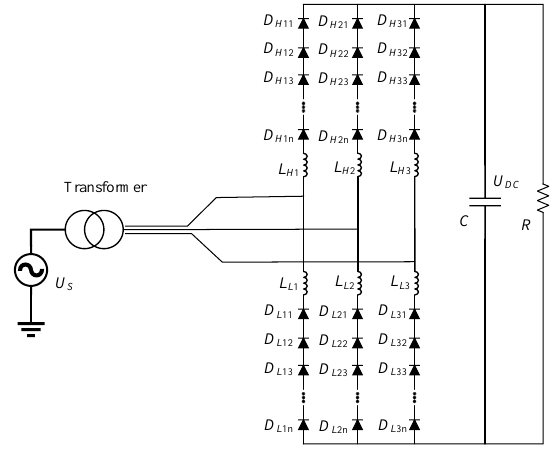
Figure 1. Structure of high-voltage diode rectifier.